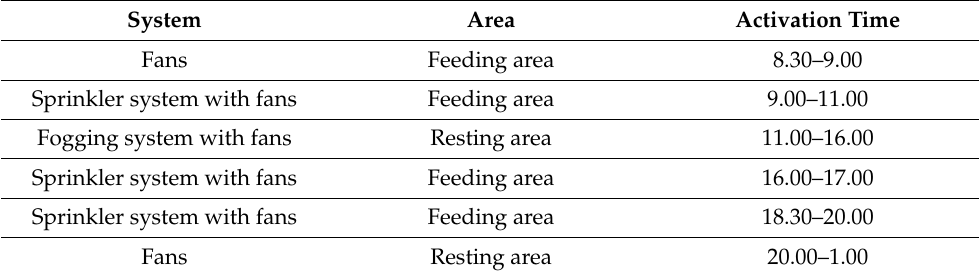
Table 1. Timetable of the two cooling systems in the two